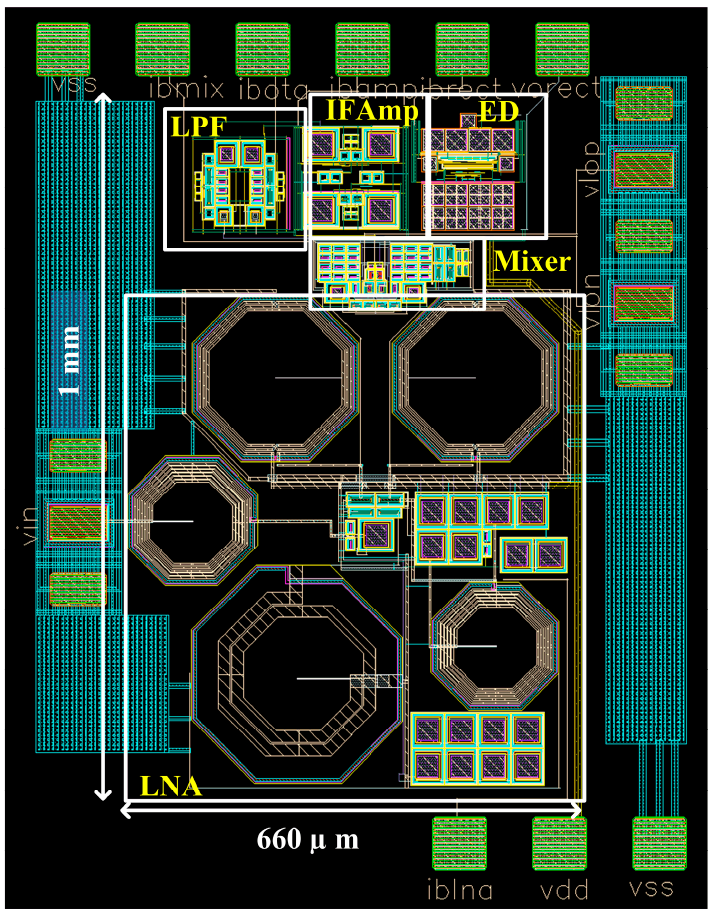
Figure 17. Layout of the complete designed RF-FE.